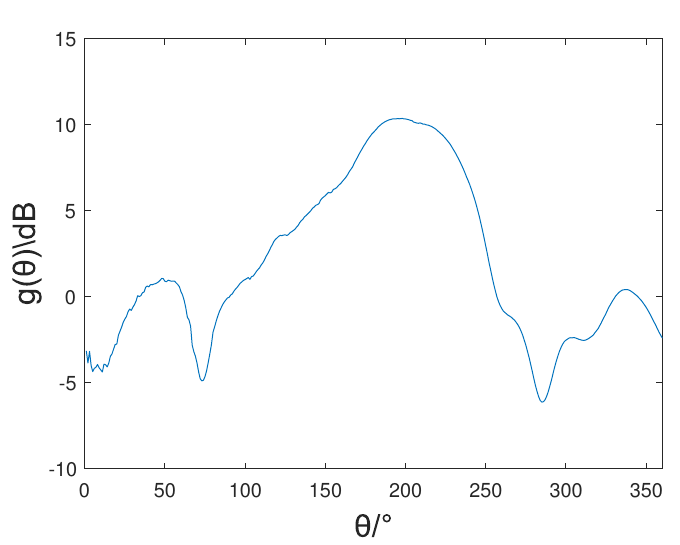
Figure 11. The measured